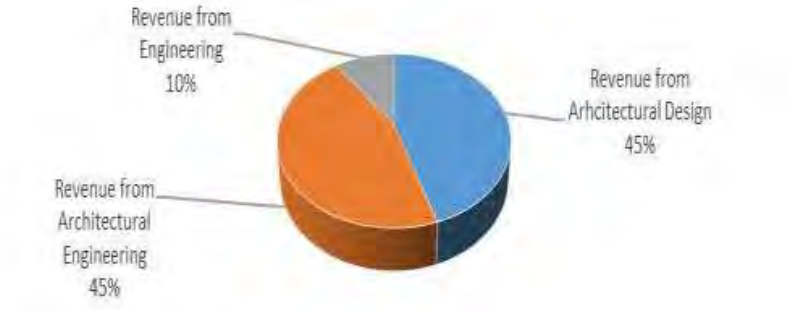
Figure 7. Top Twenty Firms in 2016 Survey Revenue